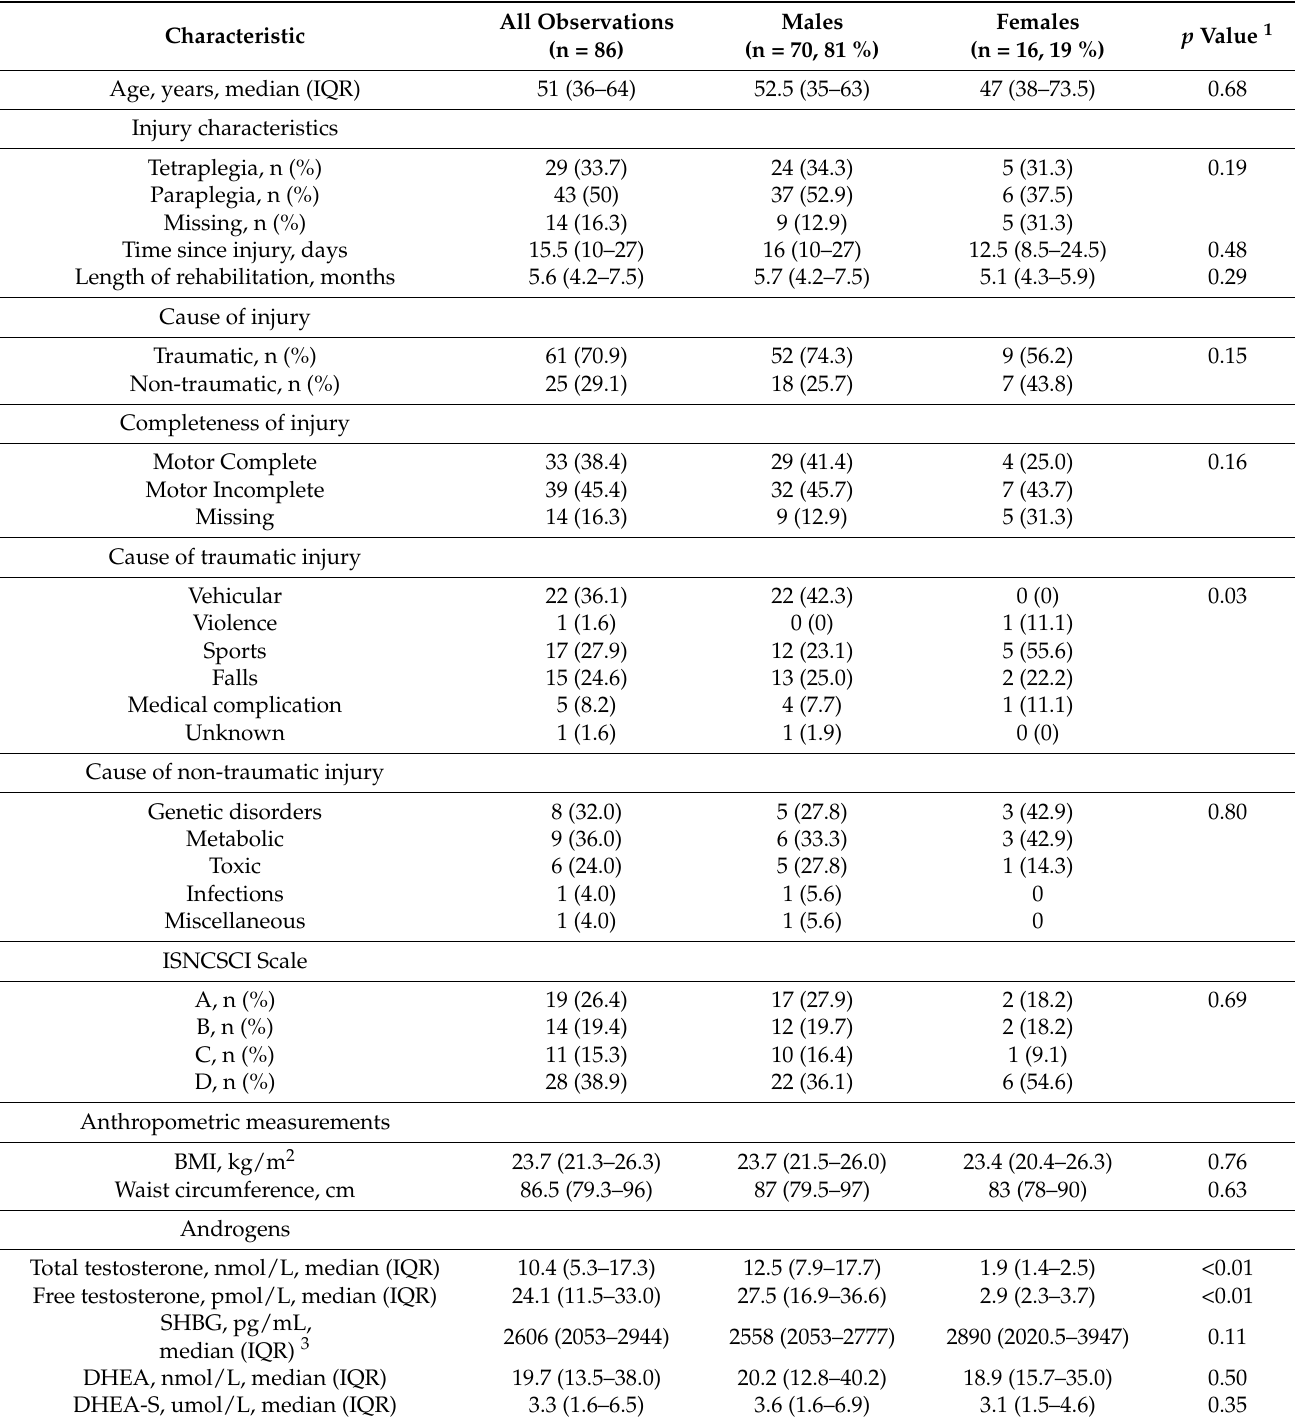
Table 1. Baseline Characteristics of the SCI individuals (beginning of